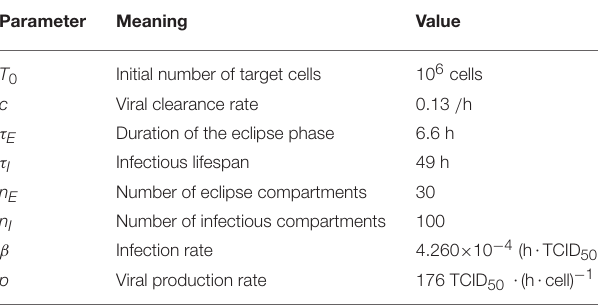
TABLE 1 | Parameter values used for simulations.